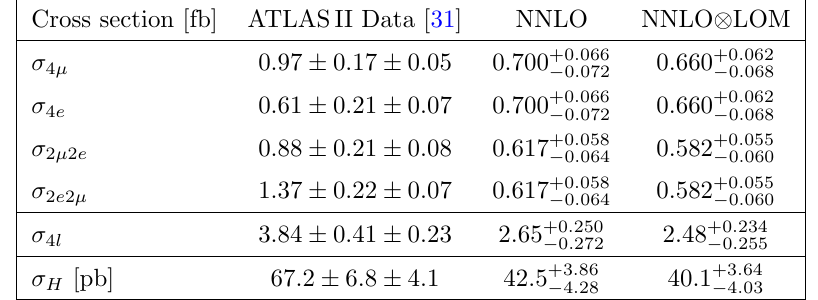
Table 2. The fiducial cross section of Higgs boson production measured in the four-lepton final state using ATLAS II fiducial cuts listed in table 1. The decay channel of 2 e 2 µ is distinguished from 2 µ 2 e by requiring the first lepton pair being the Z 1 candidate as described in section 2.3. Experimental errors are statistical and systematic. Theoretical uncertainties are from scale variation as described in the